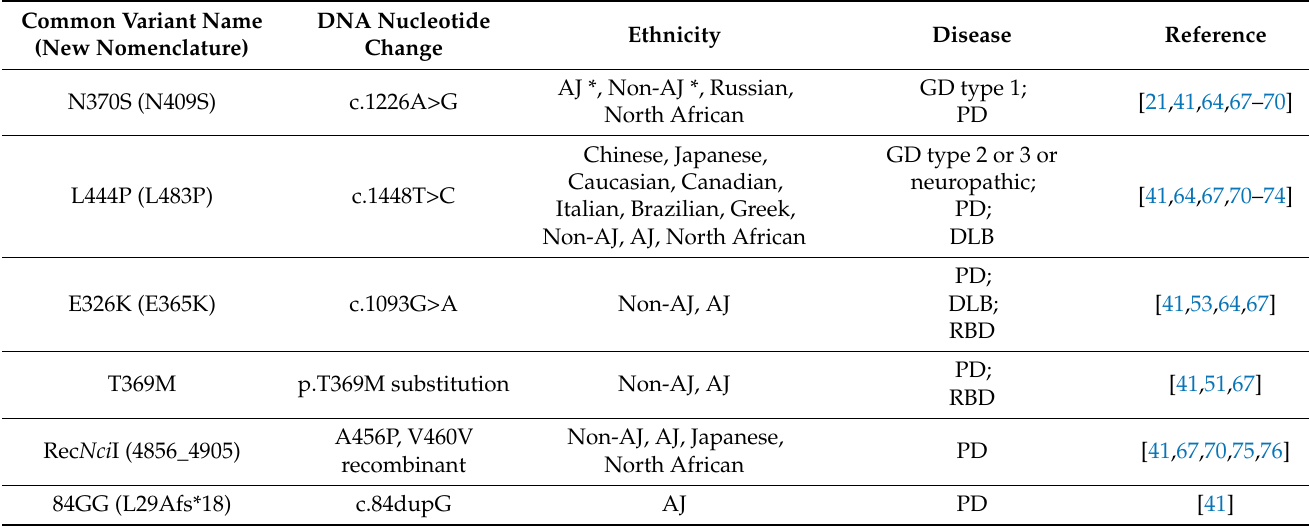
Table 1. The most common GBA1 mutations, their prevalence in various populations and association with the specific